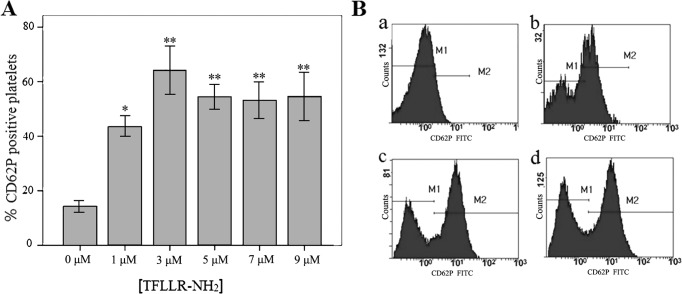
Flow cytometry detection of CD62P in the platelets treated with the PAR1 agonist TFLLR-NH2. (a) CD62P expression in the platelets treated with different concentrations of TFLLR-NH2 as detected by flow cytometry (mean ± standard deviation of three independent experiments). *P<0.05 and **P<0.01. (B) Representative FACS plots for CD62P expression in the platelets activated by (a) 0, (b) 1, (c) 3 and (d) 10 μM TFLLR-NH2. M1, CD62P-negative region; M2, CD62P-positive region. PAR1, protease-activated receptor-1.